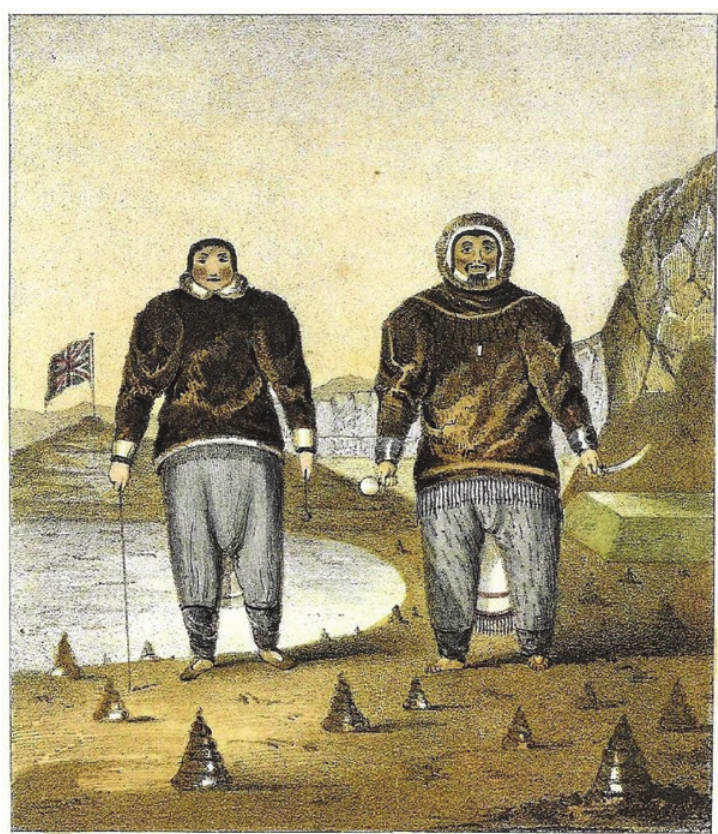
Figure 4. Two Inuit men in deerskin and sealskin. Source : Ross, Second Voyage, Appendix 31, 33, 39 and